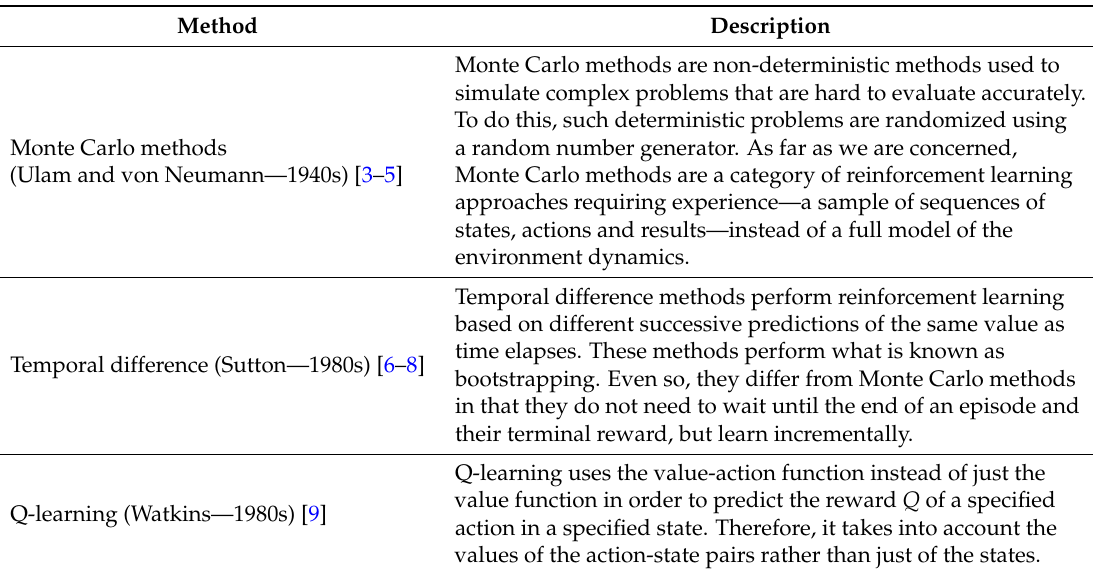
Table 1. Prominent model-free reinforcement learning